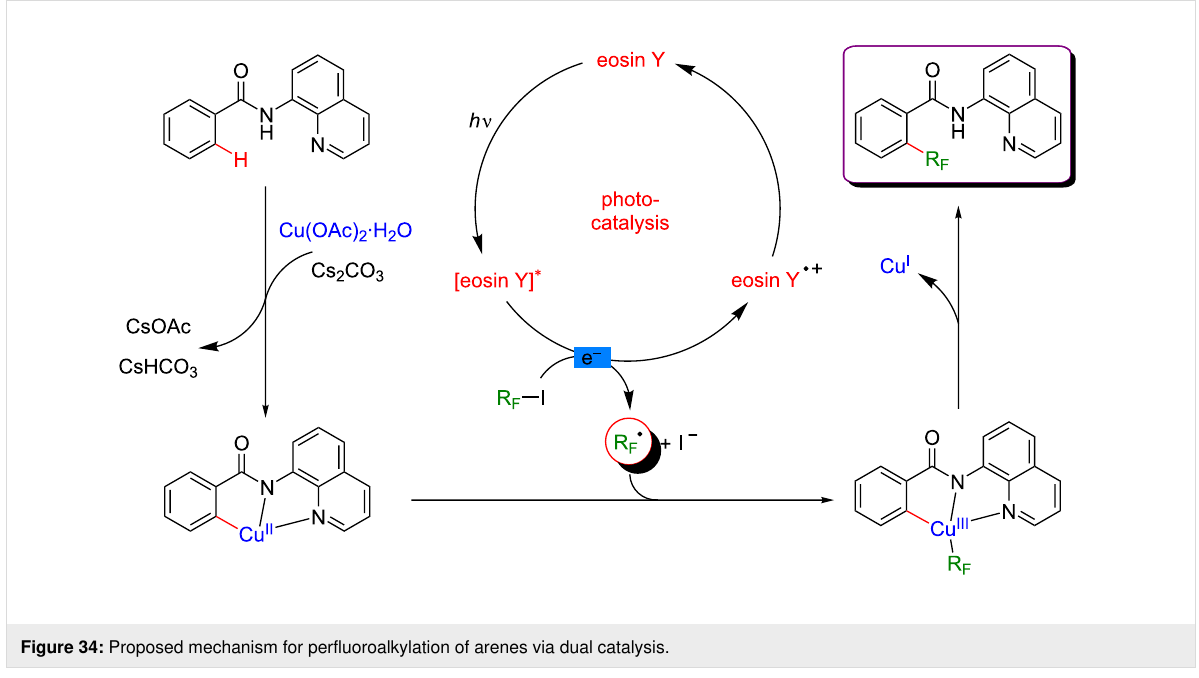
Figure 34: Proposed mechanism for perfluoroalkylation of arenes via dual catalysis.